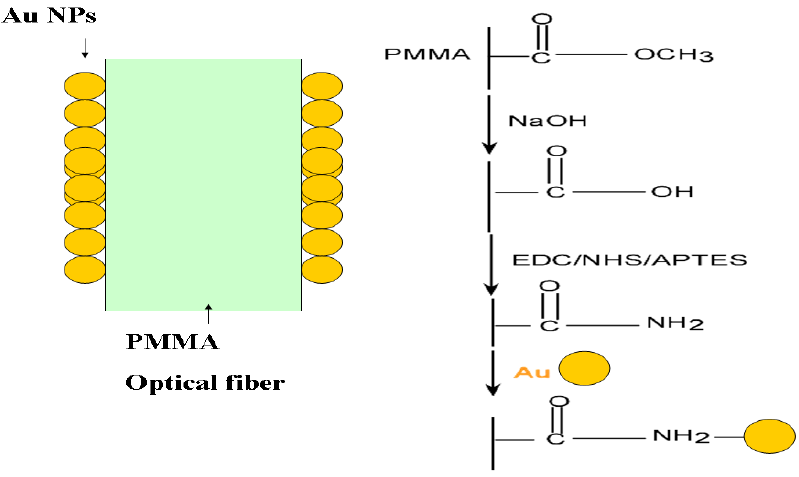
Figure 1. The diagram of gold nanoparticles immobilized on PMMA optical